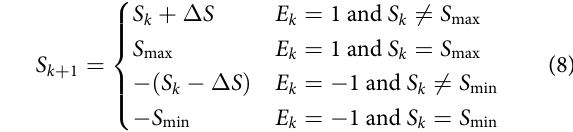
that are highlighted in Theorem 2 of Premaratne et al.